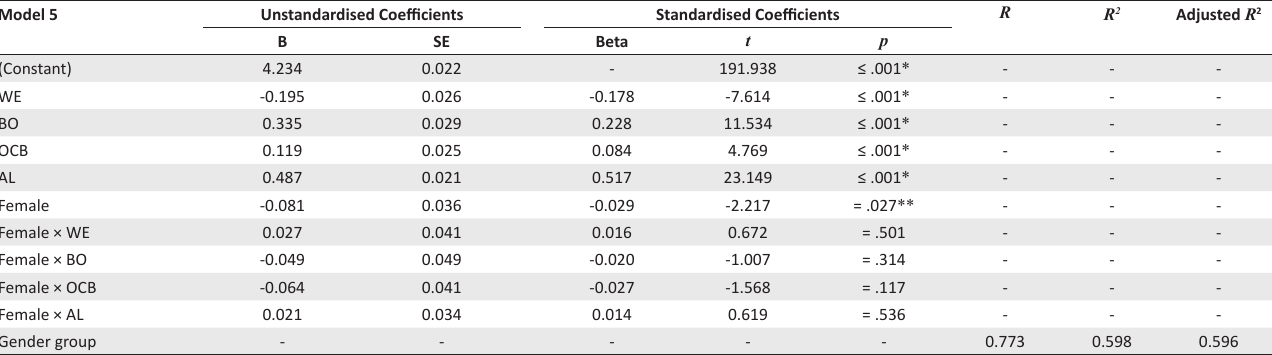
TABLE 2: Moderated multiple regression in terms of gender group. Model